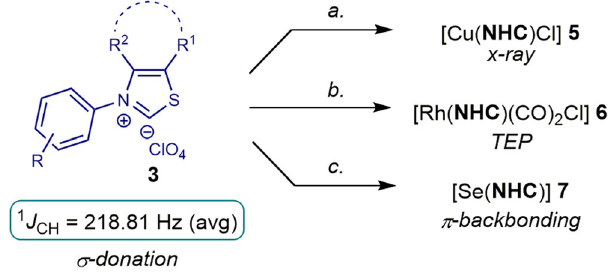
Fig. 5 Synthesis of thiazol-2-ylidene complexes. The respective experimental conditions can be found in the Supplementary Method 4 –